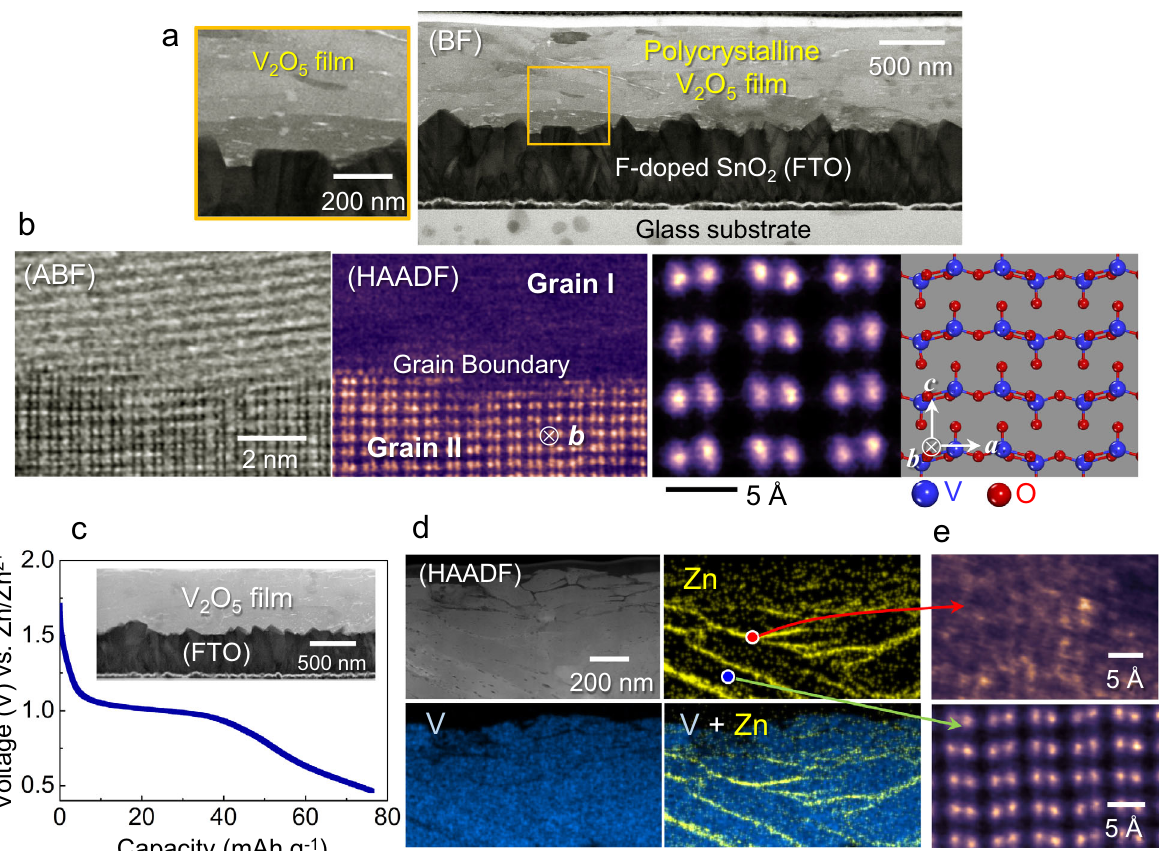
Fig. 2 V 2 O 5 thin- fi lm deposition and electrochemical Zn insertion. a The BF-STEM image and its enlargement show the polycrystalline microstructure of the V 2 O 5 fi lm deposited on a glass substrate coated with F-doped SnO 2 . b A grain-boundary region is magni fi ed in a pair of ABF and HAADF images. Grain II is aligned in the [010] projection, as shown in the atomic-column-resolved image along with a schematic illustration for atom positions. c A discharge pro fi le demonstrates the electrochemical Zn insertion into the V 2 O 5 thin fi lm. d A set of EDS maps also veri fi es the presence of Zn, showing a much higher Zn concentration in grain-boundary regions. This sample was discharged to 0.47 V. e Two atomic-scale images taken from the grain bulk (lower) and a Zn- rich grain-boundary (upper) are compared to consistently show the low crystallinity of the hydrated Zn y V 2 O 5 · n H 2 O